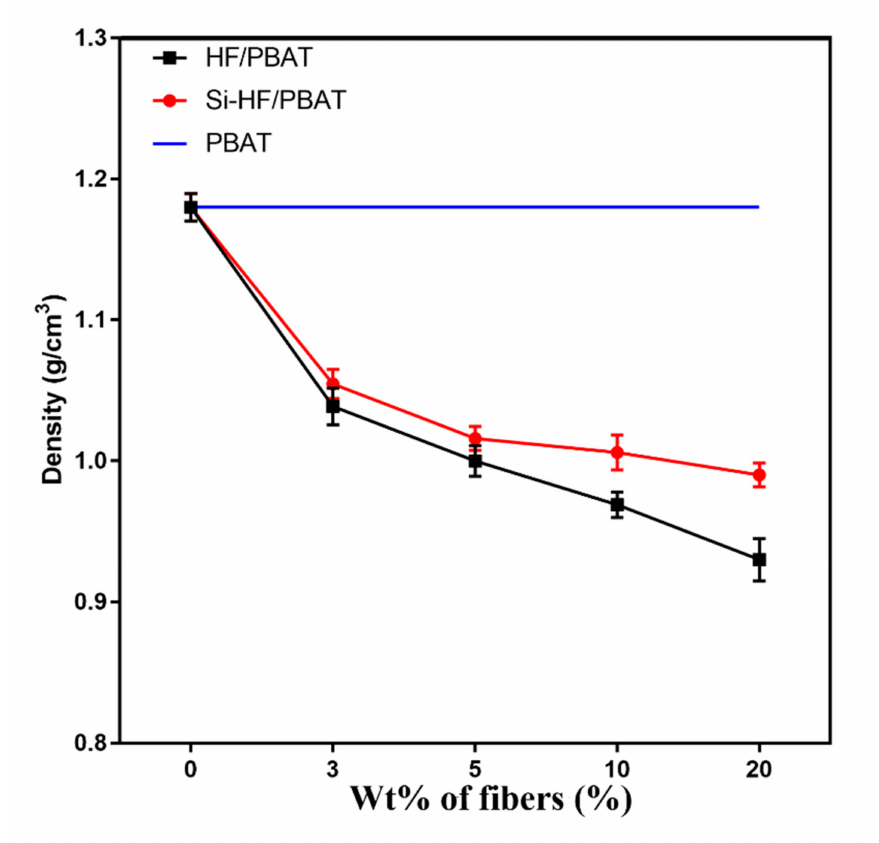
Figure 2. Density change of PBAT composites with hemp-fiber